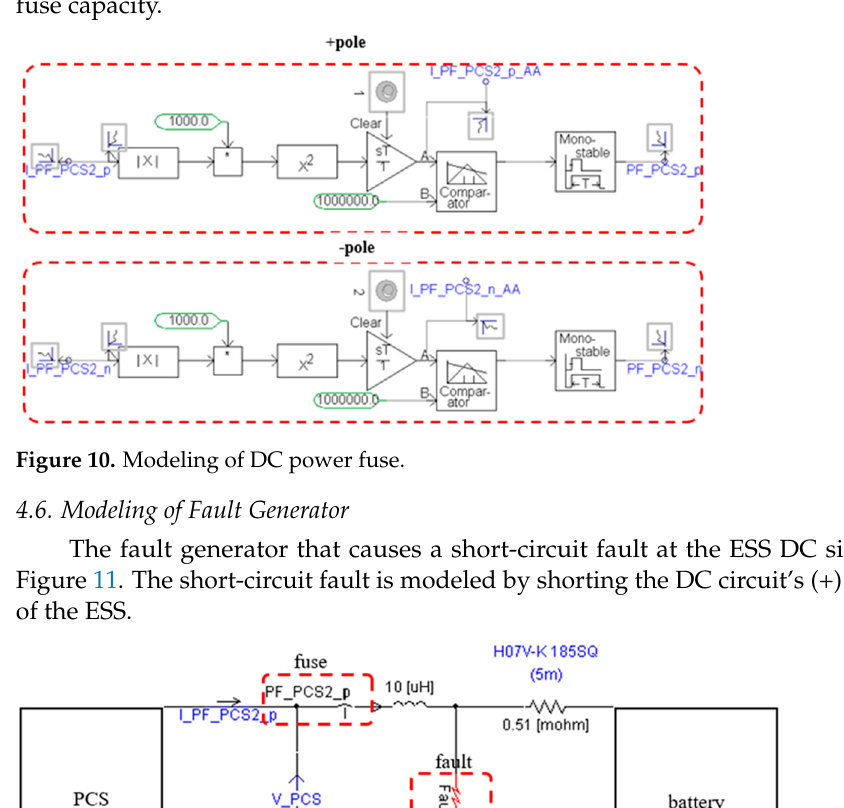
Figure 9. Battery section.